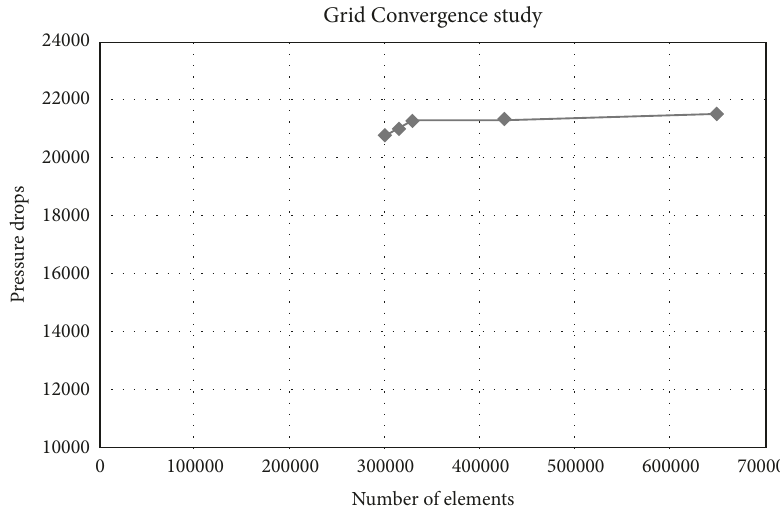
Figure 2: Grid convergence study of Avicennia mangrove